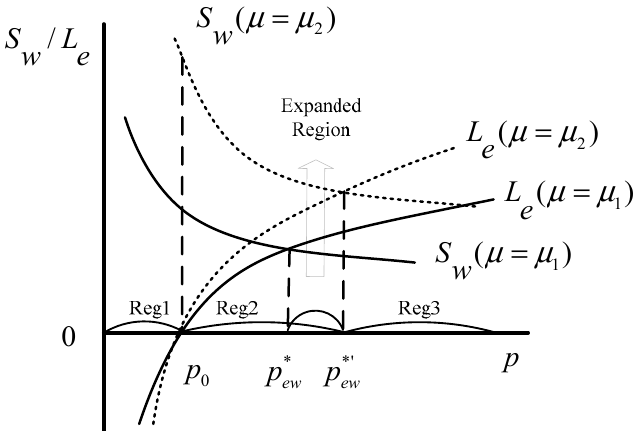
μ μ < μ on the game process ( 1 2 ).